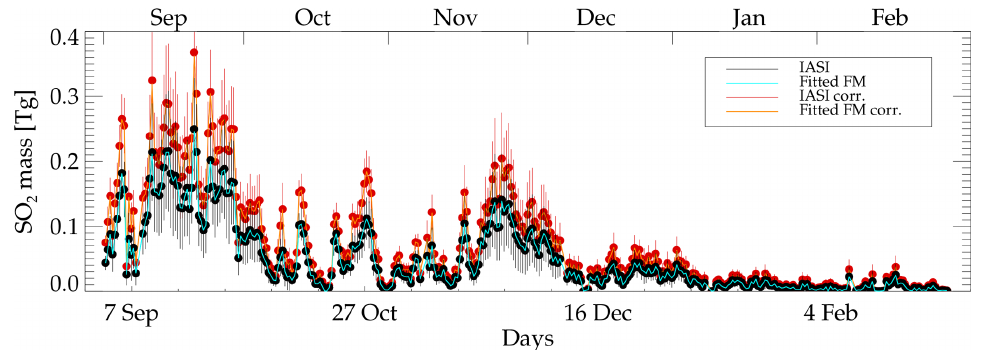
Figure 2. Time series of SO 2 mass as a function of day from 1 September 2014. The plot shows the IASI mass (obtained from the retrieval) with error bars in black and the fitting of the flux retrieval (Sect. 5) with the cyan line. Red circles and orange line show the masses corrected for cloud presence and their fitting of the